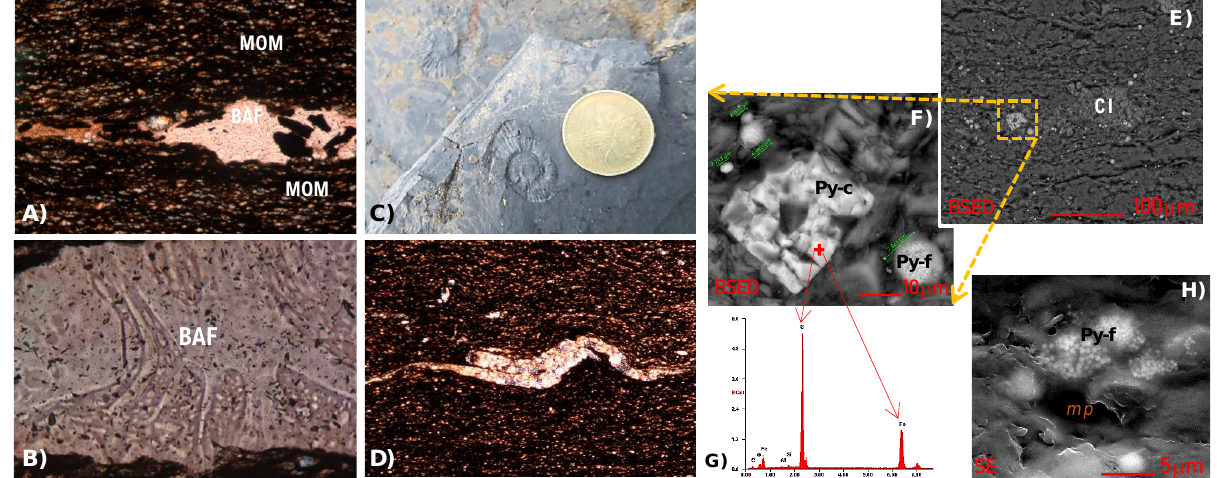
Figure 5. Details of texture, structure, composition, and fossils in the mudstones of the Paja Formation. ( A ) A 1.3 mm brown algae fragment (BAF) seen in thin section, within microbiolytic organic matter (MOM) and phyllosilicates, silt and clay sizes: corroded and partially replaced by CaCO 3 , pyrite, and siderite at the edges red wine color (magnified 10 × ); ( B ) with ellipsoidal zoetia and elongated avicularia, zircons, and other accessory minerals (40 × , also in XPL). ( C ) Ammonites: above, in molds in the gray mudstone (coin diameter 20.3 mm); ( D ) double shell (max. thickness 20 microns, in 5 × XPL) in high carbonate birefringence colors. On the right, SEM of another claystone with iron sulfides and a few layers of MOM: ( E ) compacted intraclast (CI) with pyrite of cubic (Py-c) and iron sulfide. ( H ) intergranular microporosity (mp) in “fresh” rock, and unaltered iron